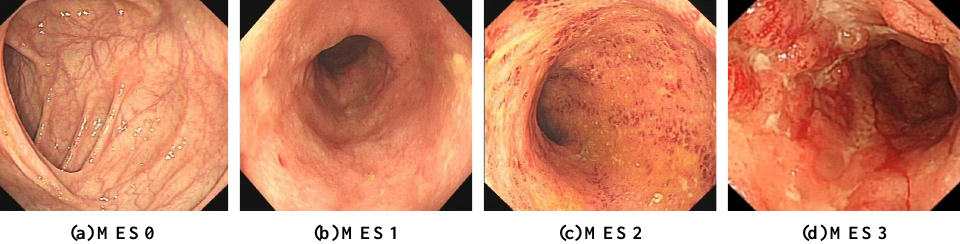
Figure 1. Representative images of Mayo endoscopy score. ( a ) MES 0: normal or inactive; ( b ) MES 1: mild, erythema, decreased vascular pattern, mild friability; ( c ) MES 2: moderate, marked erythema, absent vascular pattern, friability, erosions; ( d ) MES 3: severe, spontaneous bleeding,